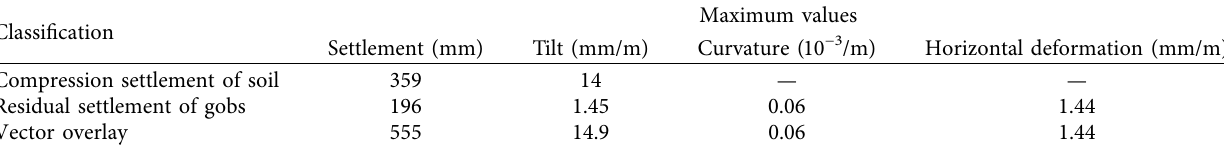
Table 3: Maximum settlement and deformation of the foundation below the office